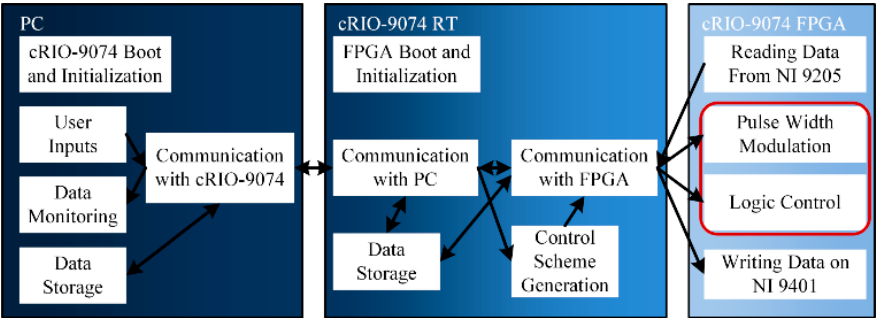
Figure 16. Tasks utilized on PC, cRIO-9074 RT, and cRIO-9074. personal computer (PC), Real-Time (RT), and field programmable gate array (FPGA).